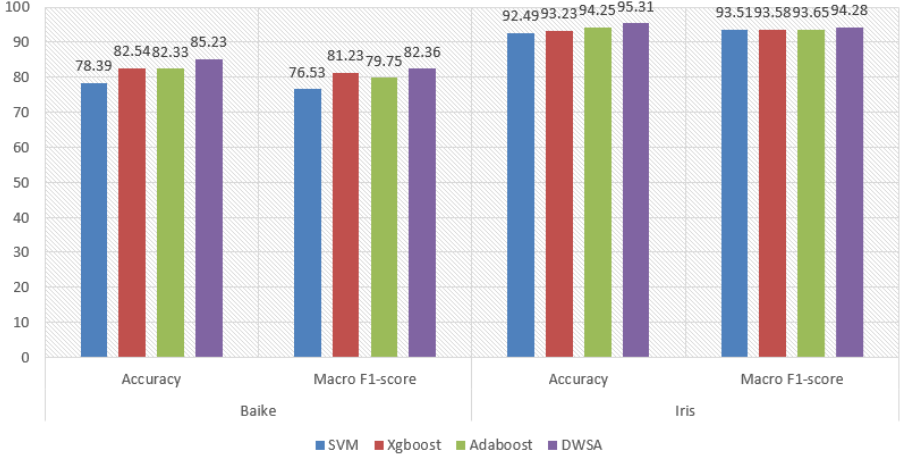
Figure 6. The result of the algorithm comparison experiment on the public data set Baike2018qa and